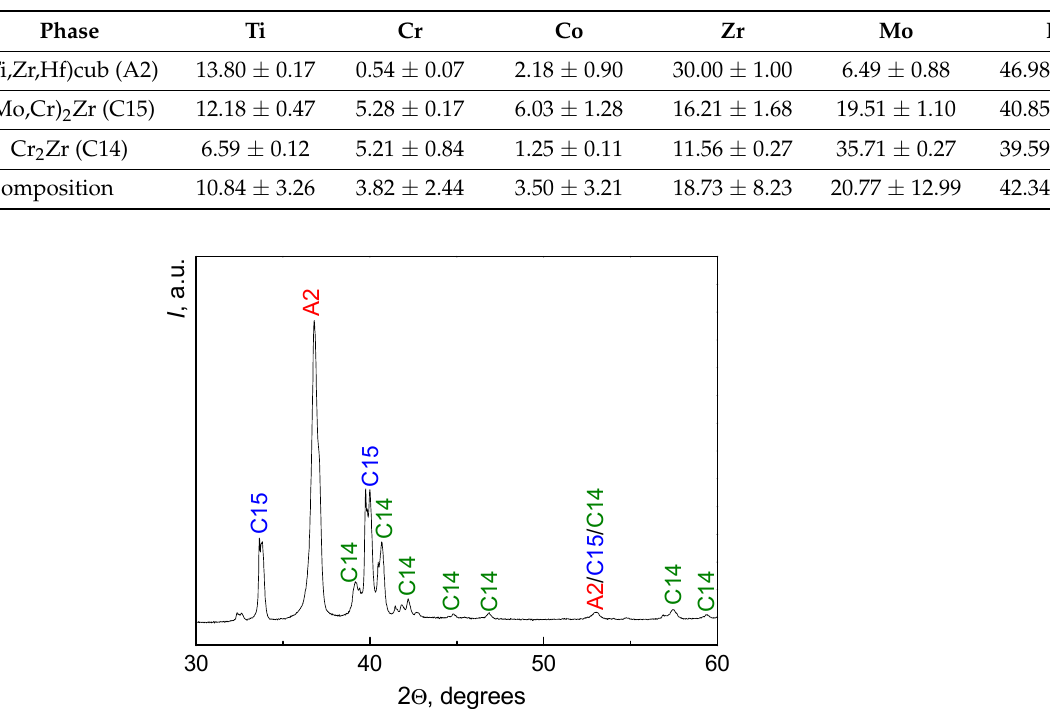
Figure 1. SEM micrographs of the as-cast TiZrHfMoCrCo alloy: ( a ) general view, ( b ) the compo- nent analysis areas are marked with dots: light gray ( 1 ), dark gray ( 2 ), and gray ( 3 ) areas.